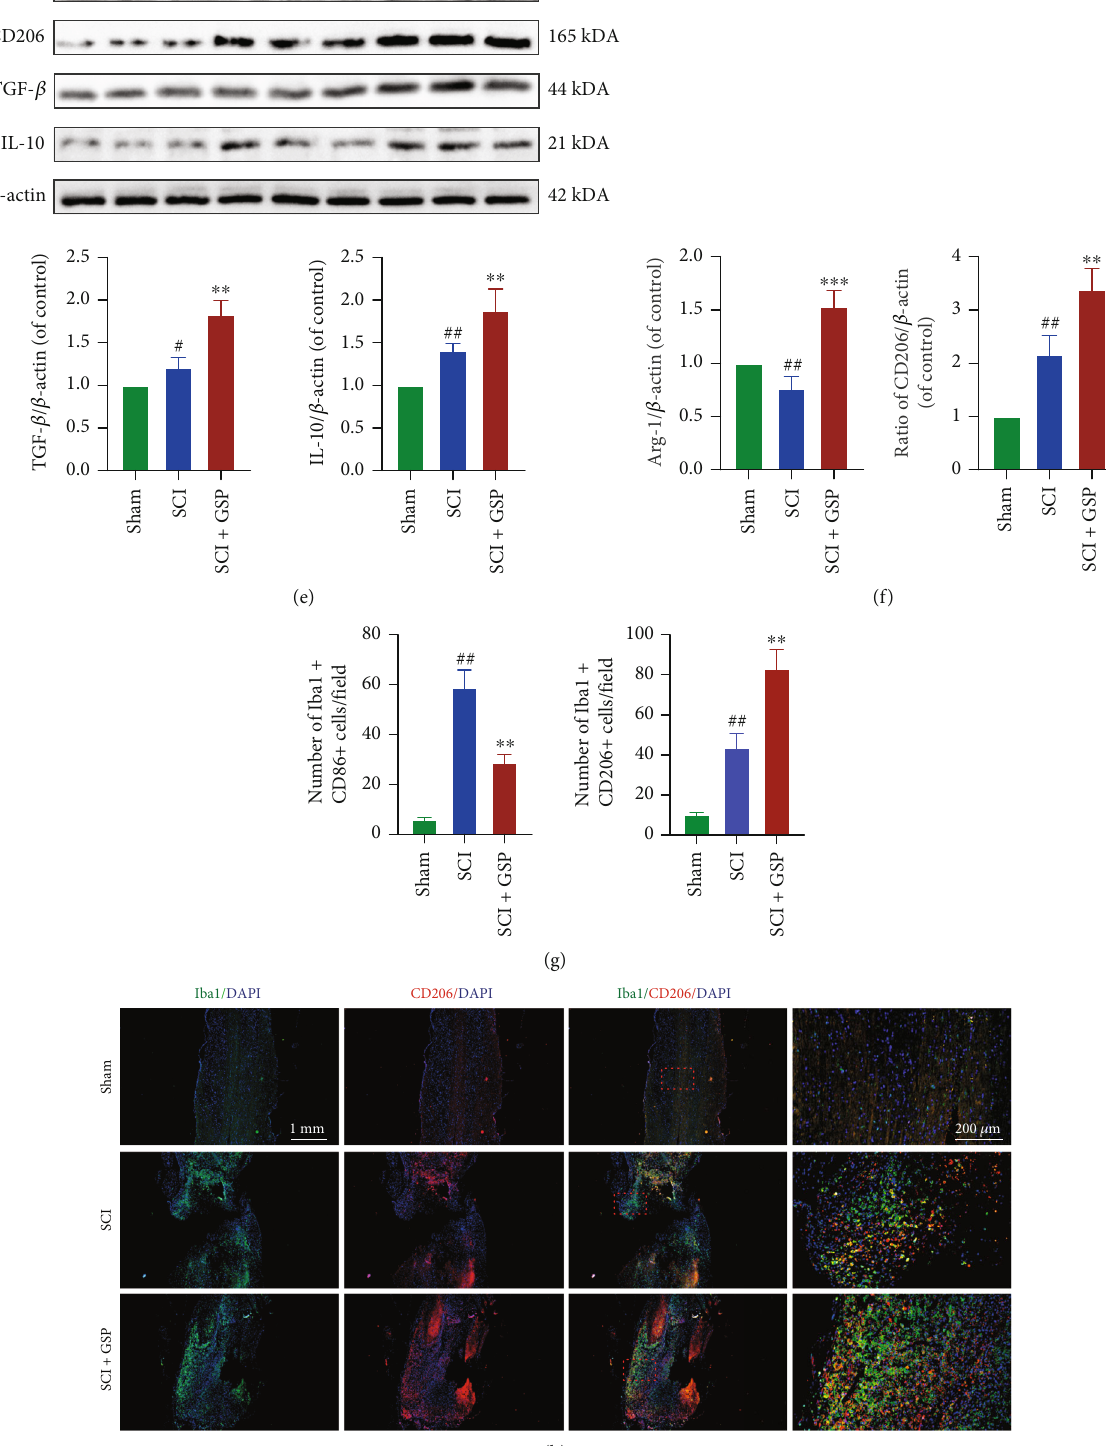
Figure 4: E ff ect of GSP on microglial polarisation in vivo . (a) The M1/M2-related mRNA expressions were measured by qRT-PCR ( n = 3 /group). (b, c, e, f) Representative WB and quantitative data of M1/M2-related protein levels in each group. ( n = 3 /group). (d, g, h) Representative IF and quantitative data of CD86/CD206 at 14 dpi and ( n = 3 /group). # p < 0 : 05 , ## p < 0 : 01 vs. sham group. ∗ p < 0 : 05 , ∗∗ p < 0 : 01 , or ∗∗∗ p < 0 : 001 vs. SCI